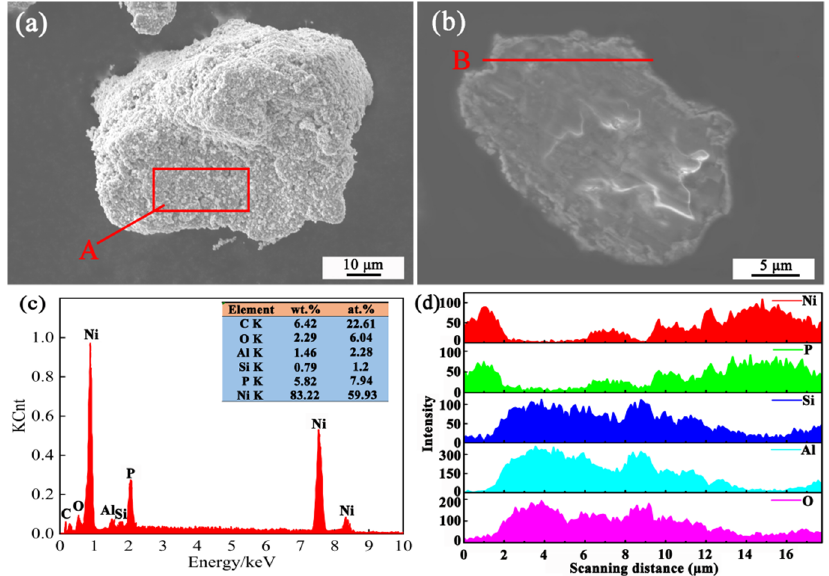
Figure 4. EDS analysis of the Ni–P/mullite composite powder: ( a ) surface, ( b ) cross section, ( c ) EDS of area A, and ( d ) scans along line B.